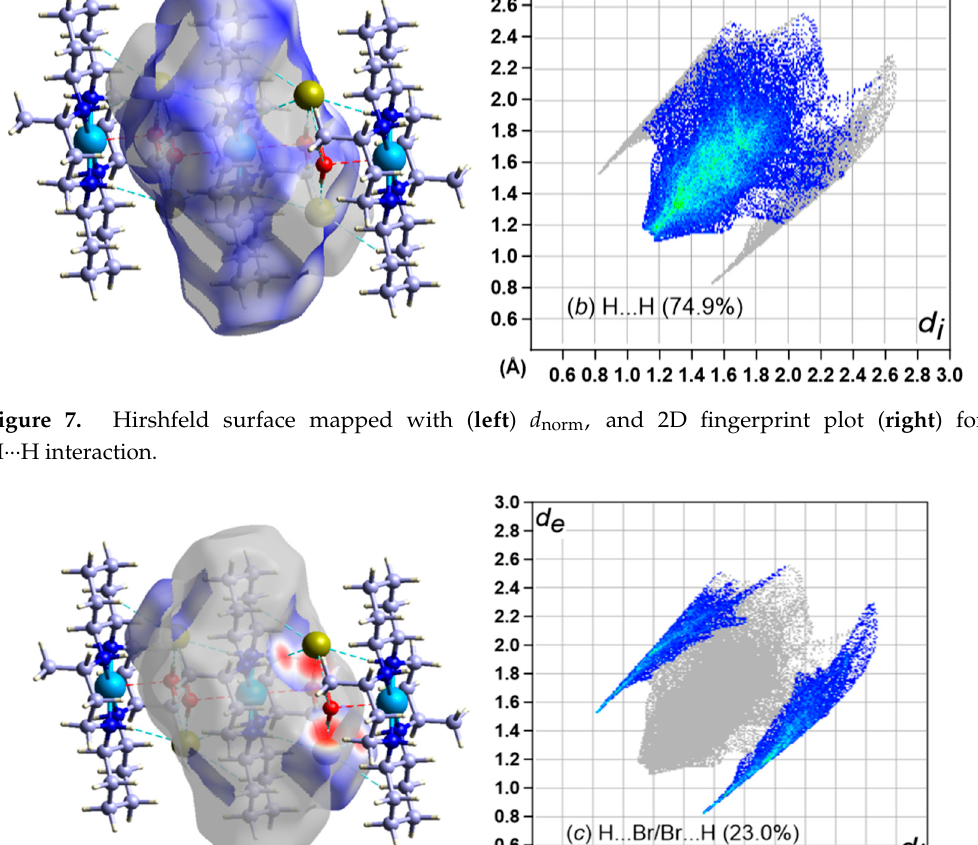
Figure 9. Hirshfeld surface mapped with ( left ) d norm , and 2D fingerprint plot ( right ) for H···O/O···H interactions.